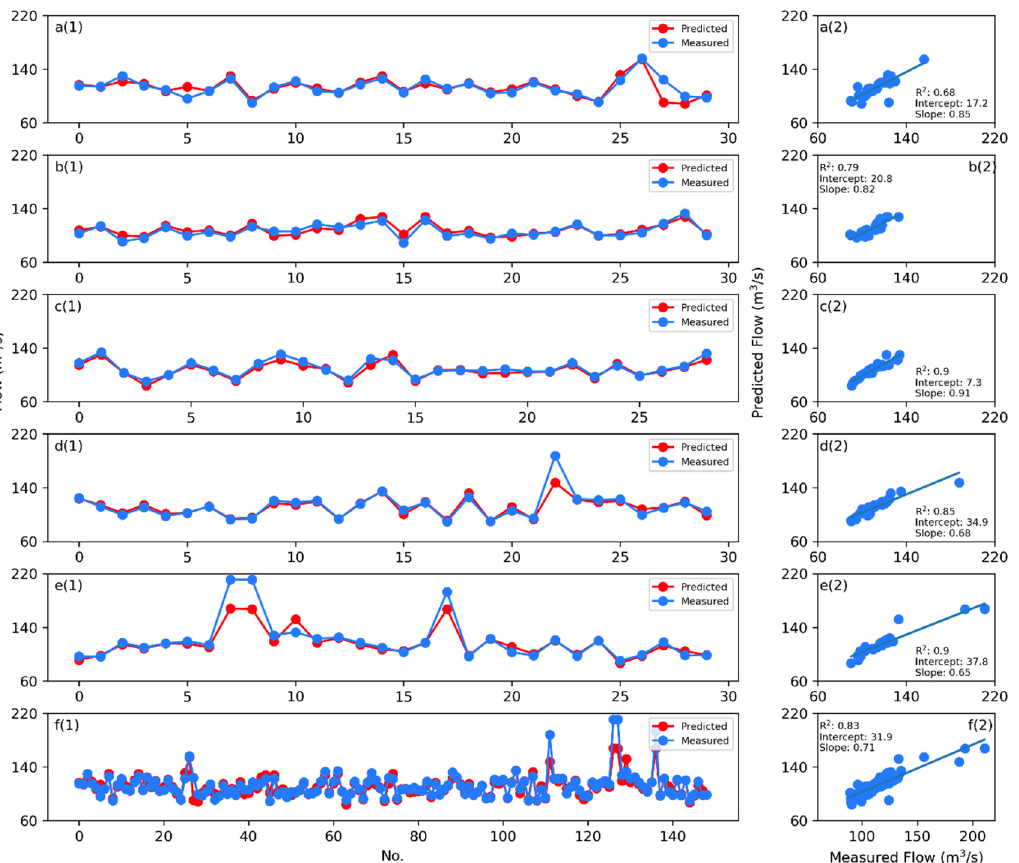
Figure 4. Comparison of the predicted values and the measured values in the low-water period. a(1) , b(1) , c(1) , d(1) and e(1) are the predicted and measured values for k1 to k5 folds, respectively, and f(1) is the predicted and measured values for all validation sets. a(2) , b(2) , c(2) , d(2) and e(2) are the scatter plots of the predicted and measured values for k1 to k5 folds, respectively, and f(2) is the scatter plot for all validation sets from k1 to k5.